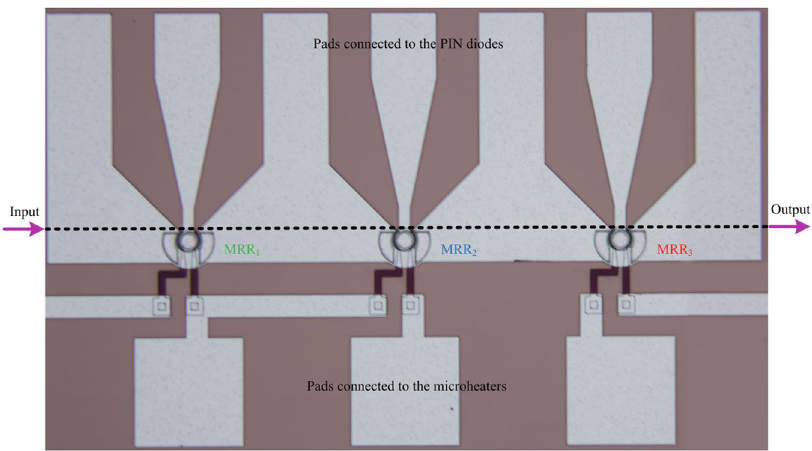
Figure 3. Microscope image of the fabricated reconfigurable electro-optic directed logic circuit based on silicon